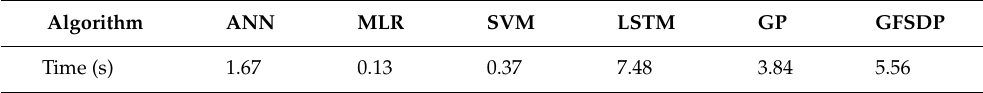
Table 6. Compared feature training and testing times between the proposed and conventional